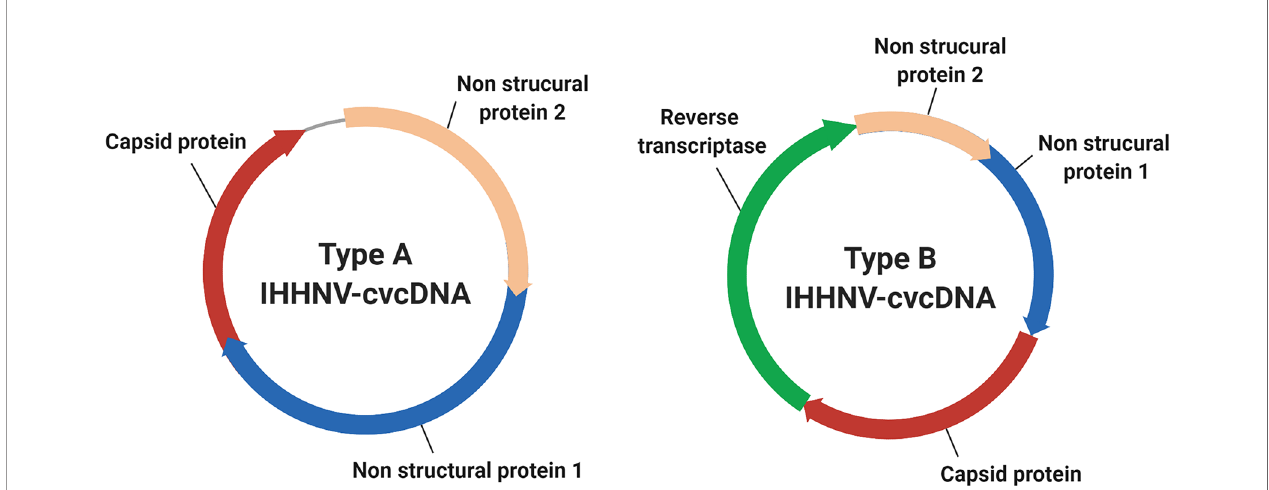
FIGURE 9 | Diagram representing the two general types of cvcDNA produced in our IHHNV-infected P. monodon. Type A contained only DNA with sequences with 98-99% sequence identity to a currently extant species of IHHNV. Type B contained DNA with 98-99% sequence identity to an IHHNV-EVE and sometimes including (as illustrated here) a portion of the linked host DNA sequence that revealed the location of the EVE in the host